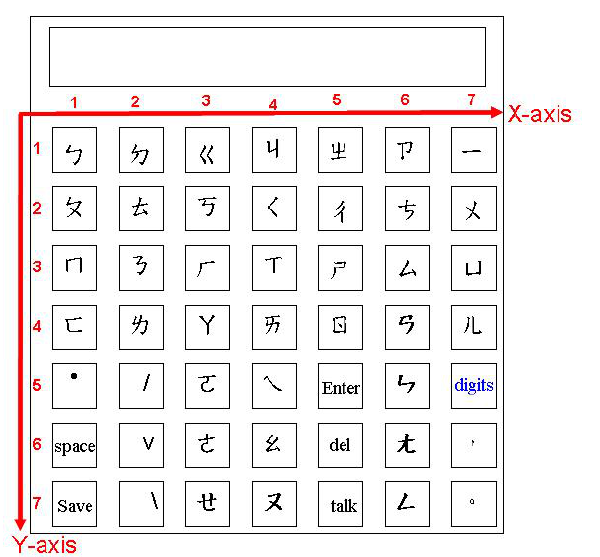
Figure 7. Chinese virtual